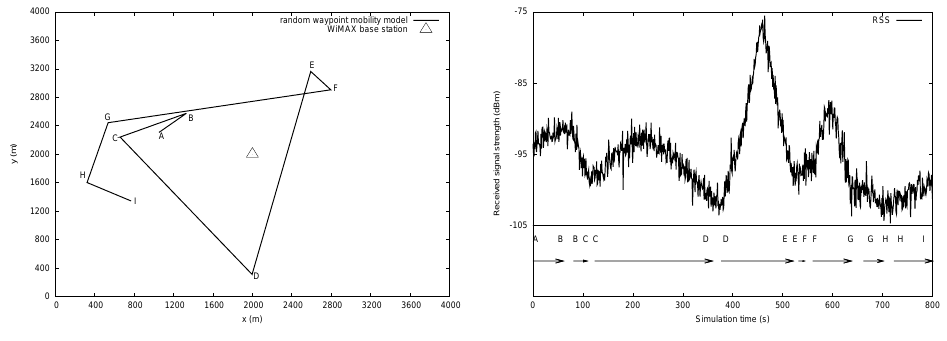
Figure 13. The feasibility analysis of MRSS in the Mobile WiMAX environment.